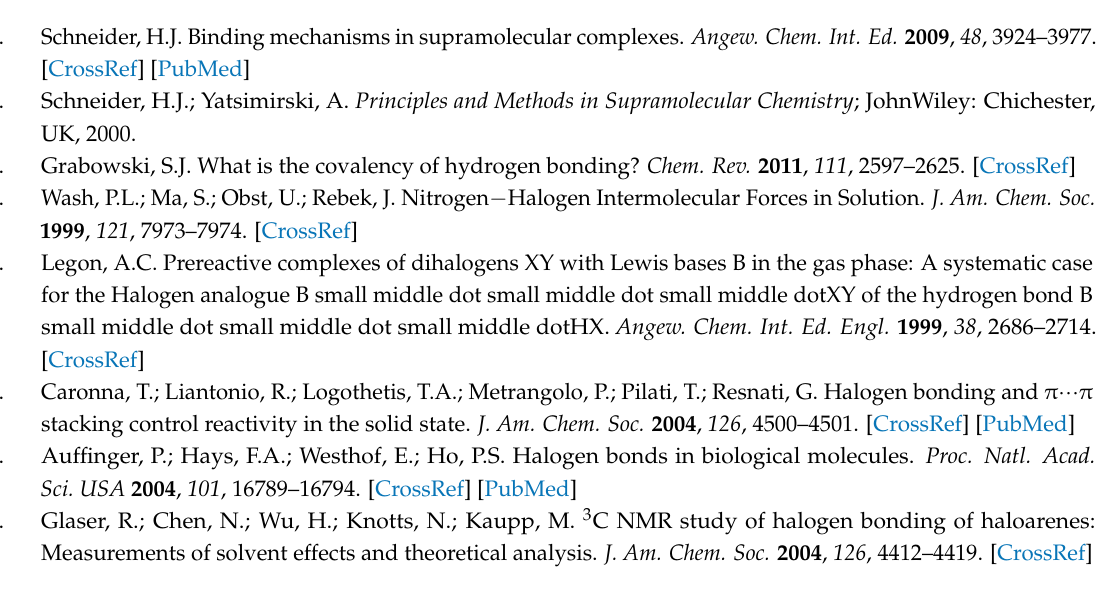
Supplementary Materials: The following are available online. Figure S1: AIM molecular graphs of axial and equatorial TF4 (T = Si, Ge, Sn) complexes with pyridine derivatives at the MP2/cc-pVTZ level. Small green dots represent bond critical points. Table S1: The delocalization index (DI) of T ··· N interaction in TF 4 complexes with pyridine and its derivatives. Data obtained at the MP2/cc-pVTZ level of theory. Table S2: Gibbs free energies of axial and equatorial conformers as well as TS for TF 4 (T: Si, Ge, Sn) complexes with Py, calculated at the MP2/cc-pVTZ level of theory. Table S3: Secondary minima for TF 4 complexes with pyridine and its derivatives. Data obtained at the MP2/cc-pVTZ level of theory. E int corrected for BSSE (in kcal/mol). Parameters: distances in Å, angles in degrees. Table S4: Interaction energies (E int , kcal mol − 1 ) corrected for BSSE calculated at the MP2/cc-pVTZ (I), BLYP-D3/Def2TZVPP (II) and B2PLYP/def2TZVPP (III) levels of theory. Table S5: Molecular coordinates for minima of primary TF 4 complexes with pyridine and its derivatives. Data obtained at the MP2/cc-pVTZ level of